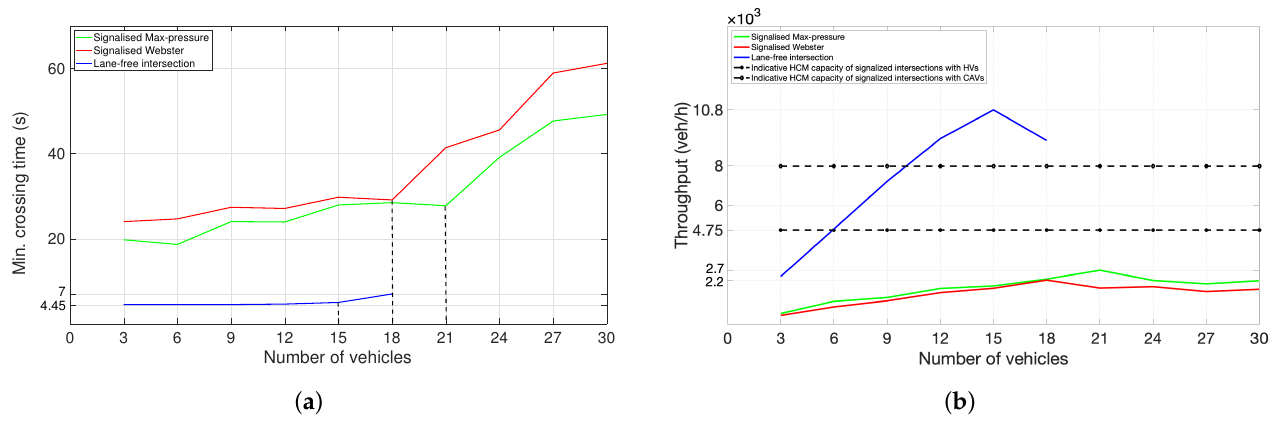
Figure 3. ( a ) The calculated crossing times by the lane-free algorithm and signalised max-pressure and Webster controllers for different number of vehicles; ( b ) the corresponding throughput obtained by the proposed measure as well as HCM indicative capacity of signalised intersections for both HVs and CAVs. The headway of CAVs is assumed as 1.13 s , which is an average of the provided stochastic values in